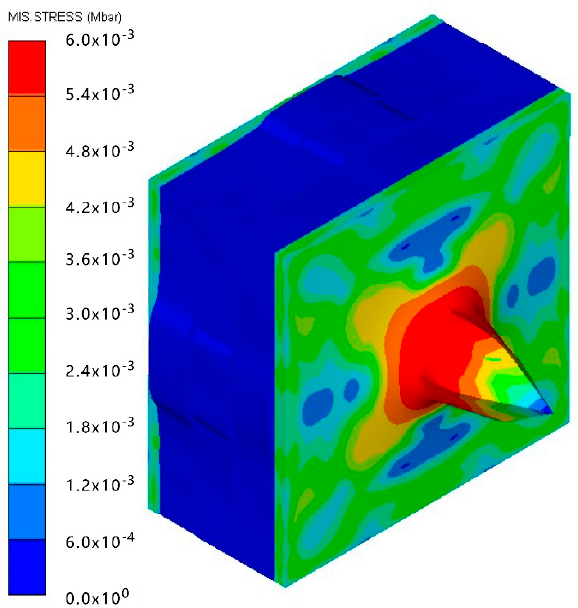
Figure 5. Von-Mises stress Contour of armor at the impact velocity of 1400 m/s.